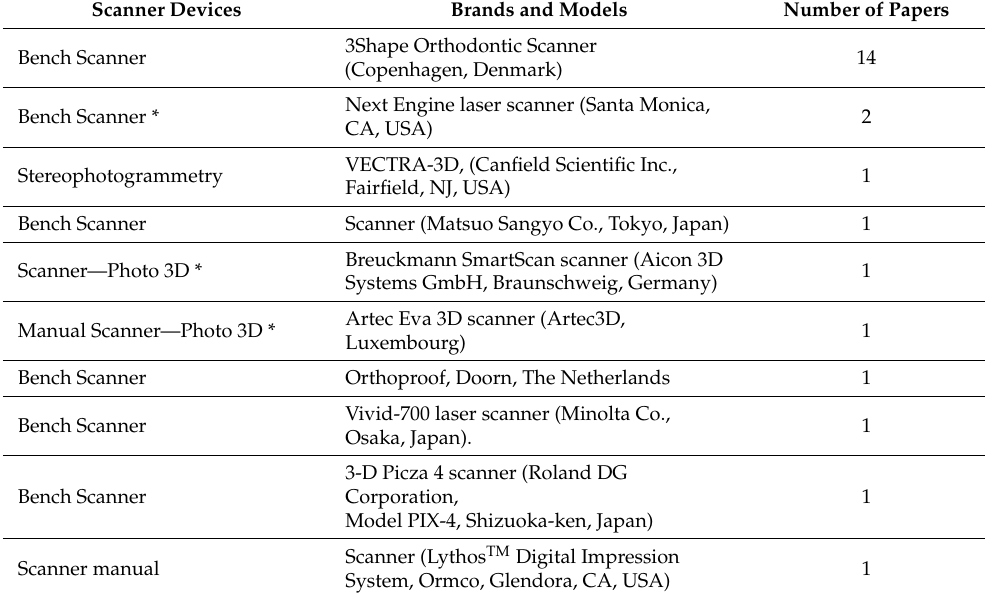
Table 2. Devices for dental arch digitalization.